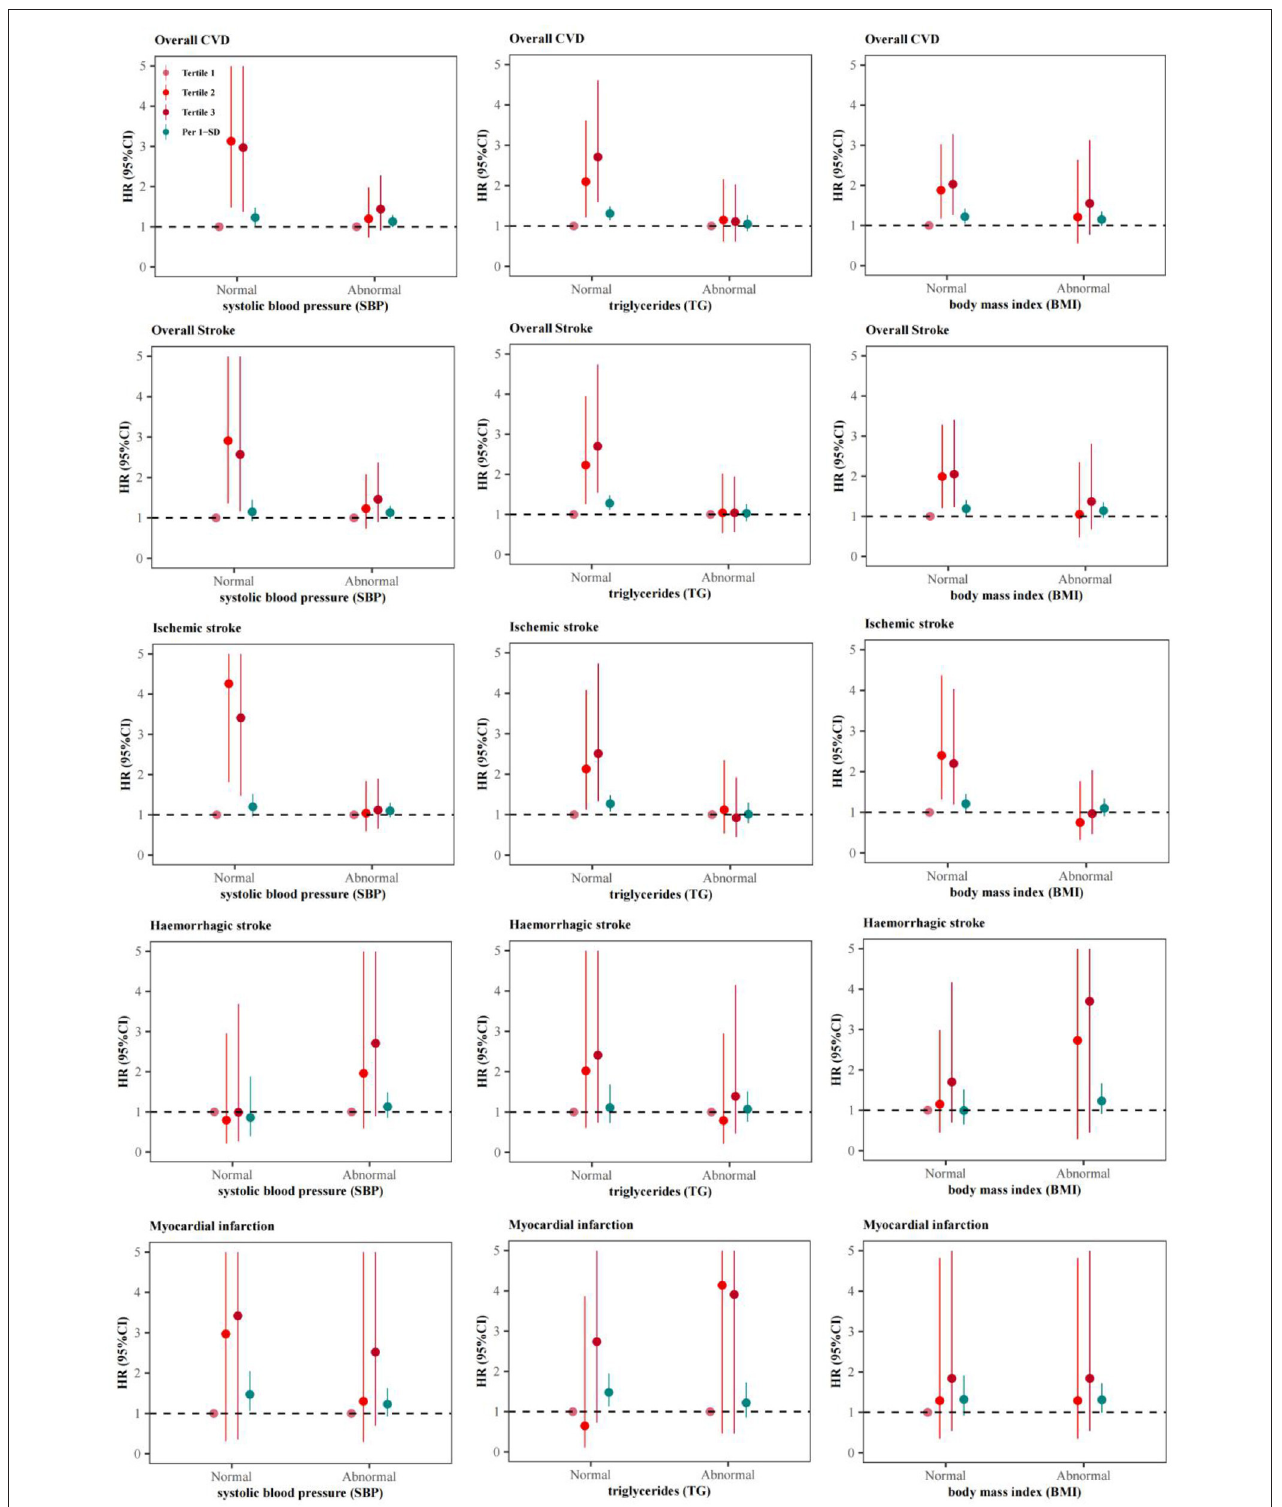
FIGURE 3 | Adjusted hazard ratios (HRs) and 95% confidence intervals (95%CIs) for cardiovascular disease (CVD) associated with baseline 2-h postload glucose (2h-PG) varied by baseline level of SBP, TG or BMI.